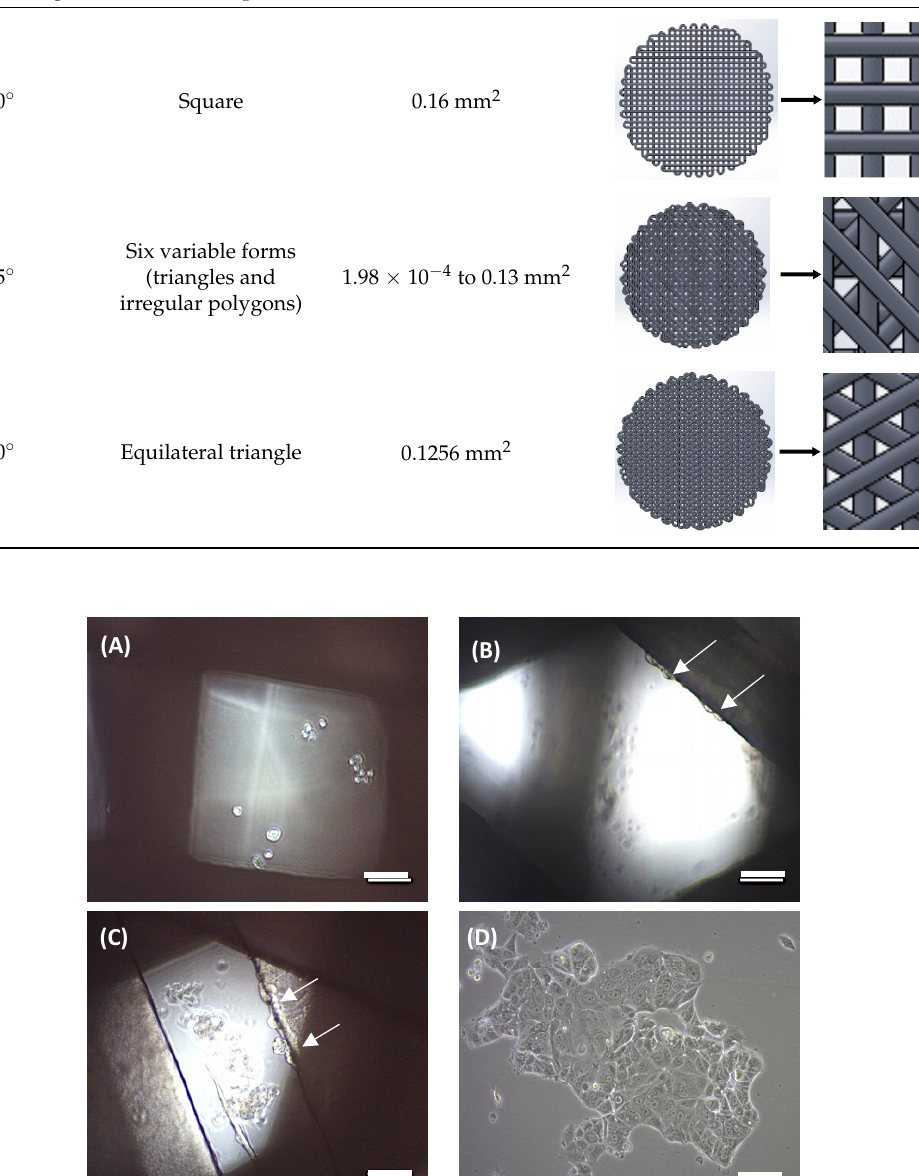
Figure 5. Optical microscope images of MCF-7 cells seeded on the scaffolds. In 90° scaffolds, cells were attached at the bottom of the well ( A ). In 45° and 60° scaffolds, cells were attached both on the scaffold and at the well ( B , C , respectively). ( D ) MCF-7 cells in 2D culture. White arrows on the images indicate cells adhered to PCL filaments. Scale bars represent 100 µm.